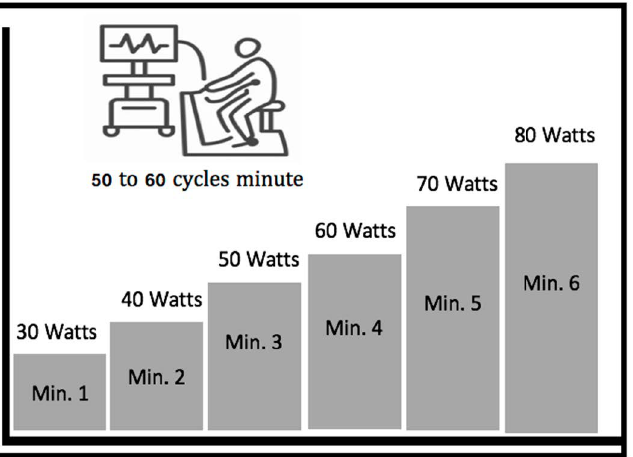
Figure 1. Ramp protocol with a 10 watts load increase per minute (aimed at elderly population with low aerobic